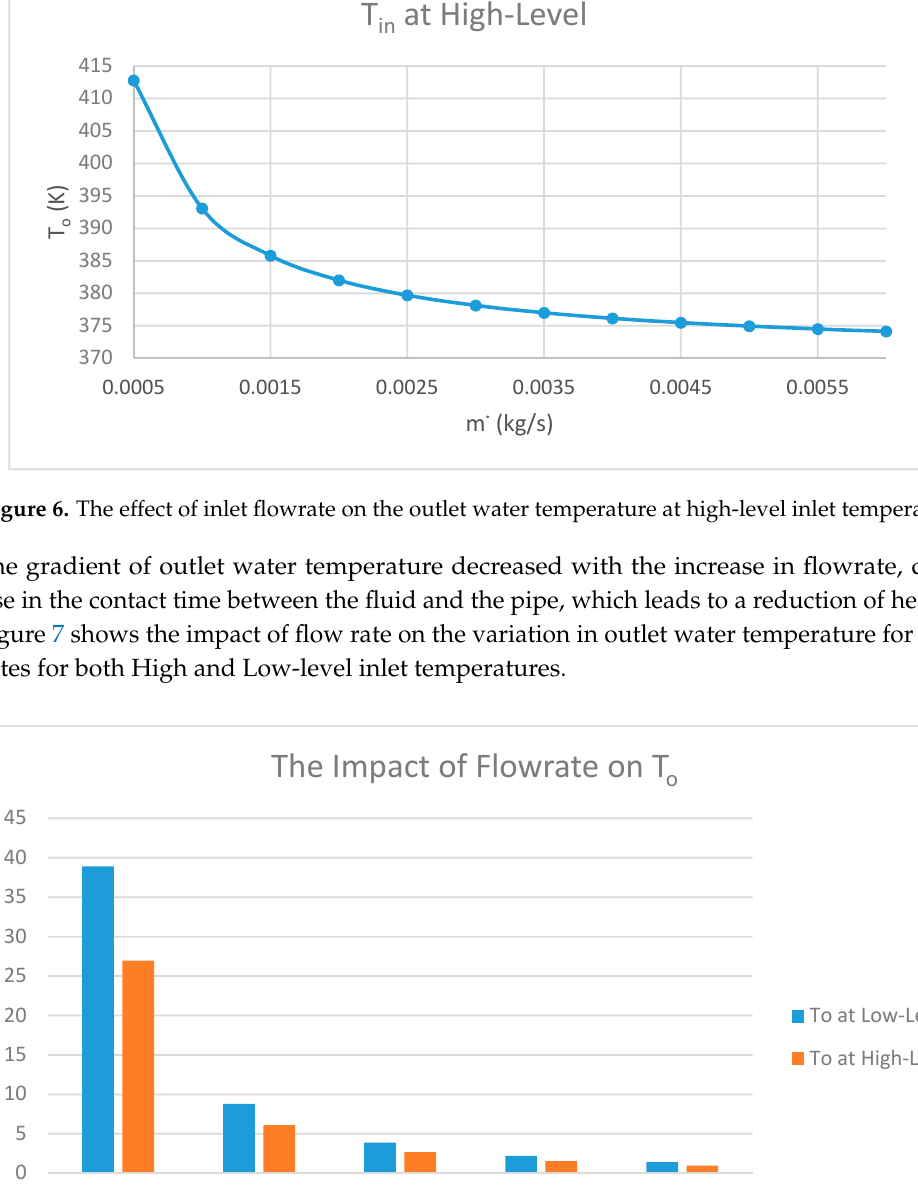
Figure 8. The effect of inlet flowrate on the outlet water temperature raise at Low-Level inlet temperature. At Low-Level inlet temperature, both the increase in inlet temperature and the gradient decreased with the increase in flowrate. A maximum increase (T o − T in ) of 43 K occurred at the minimum flowrate inside the riser pipe ( (cid:1865)(cid:4662) = 5 × 10 − 4 kg/s) at Low-Level inlet temperature while the minimum of 4.1 K occurred at the maximum flowrate ( (cid:1865)(cid:4662) = 60 × 10 − 4 kg/s) as shown in Figure 9. For all cases of flowrate, (T o − T in ) at Low-Level inlet temperature was higher than High-Level temperature.